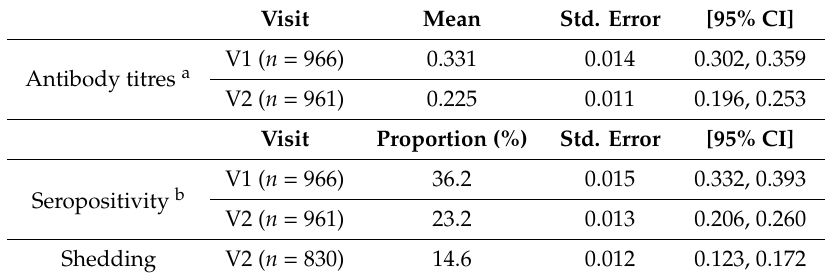
Table 2. Salmonella status (antibody titres, seropositivity, shedding) at visit 1 (V1; weaning) and visit 2 (V2; end of nursery) in nursery pigs in 50 cohorts (44 farms; 6 farms with a second cohort conducted). Visit Mean Std. Error [95% CI] V1 ( n = 966) 0.331 0.014 0.302, 0.359 Antibody titres a V2 ( n = 961) 0.225 0.011 0.196, 0.253 Visit Proportion (%) Std. Error [95% CI] V1 ( n = 966) 36.2 0.015 0.332, 0.393 Seropositivity b V2 ( n = 961) 23.2 0.013 0.206, 0.260 Shedding V2 ( n = 830) 14.6 0.012 0.123,